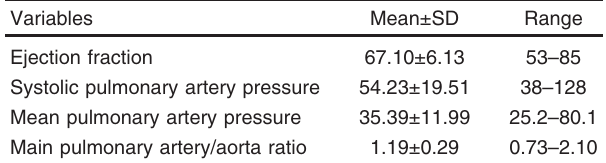
Table 4 Echocardiographic and computed tomography findings of all study